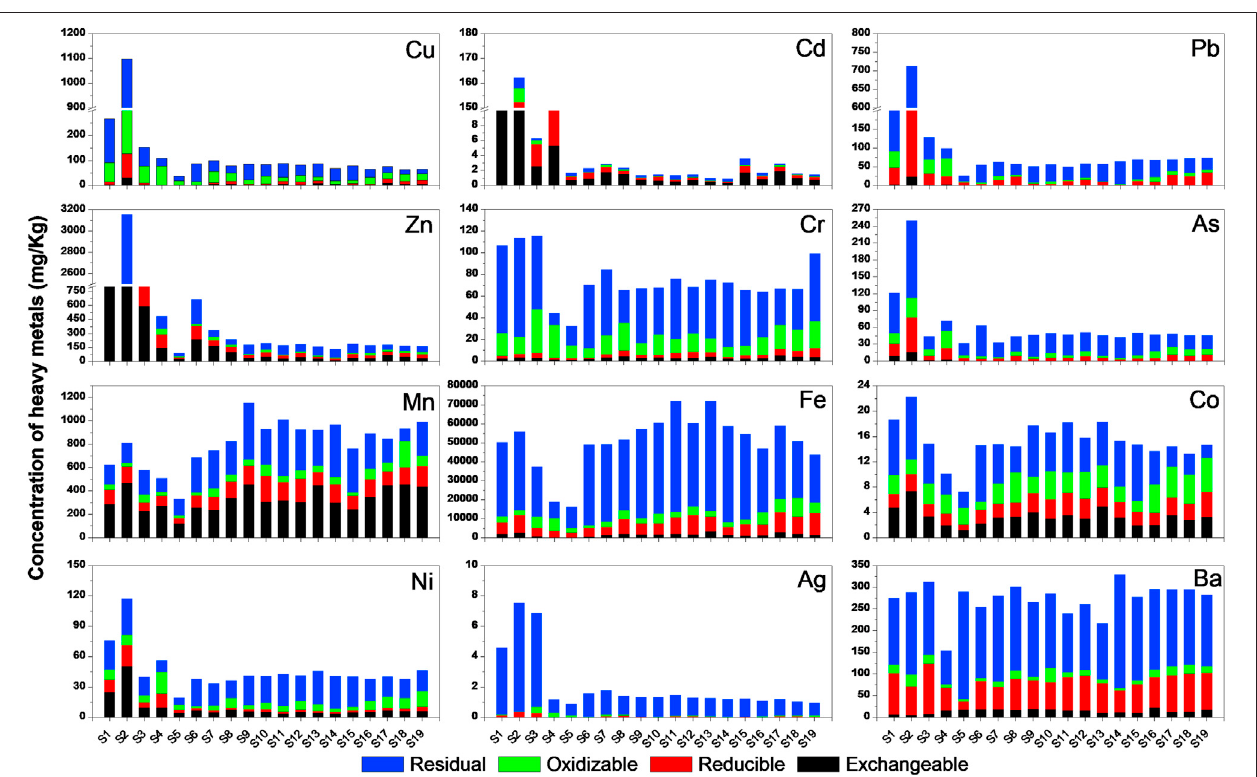
FIGURE 3 | Heavy metal concentrations in sediment samples. Blue: residual fraction; Green: oxidizable fraction; Red: reducible fraction; Black: exchangeable fraction.